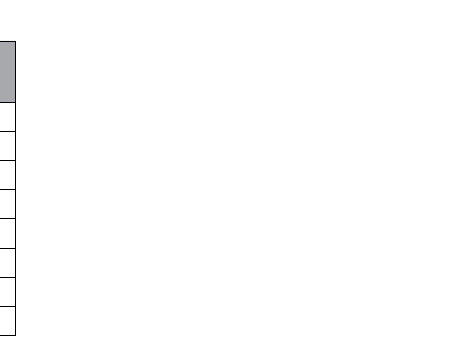
Table 5. Evaluation of the Skin friction coefficients F ′′ ( 0 ) , G ′ ( 0 ) for selected values of A